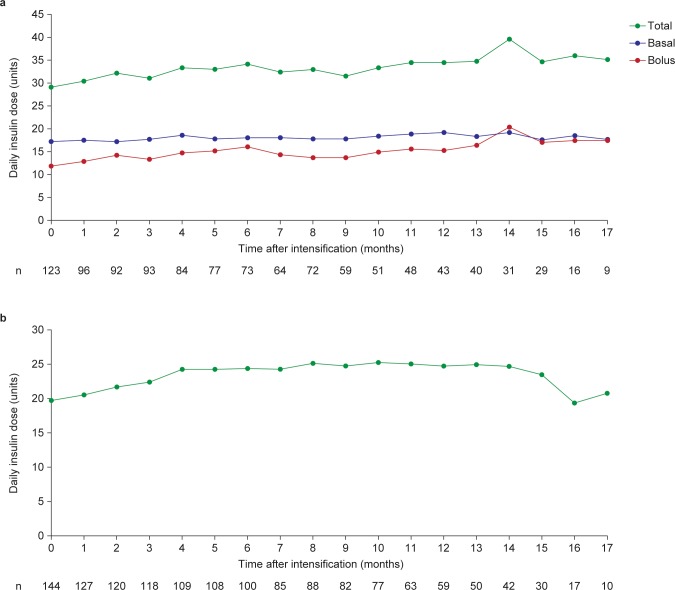
Daily insulin dose after intensification by insulin regimen a. basal–bolus insulin b. premix insulin. Data are observed mean based on the number of patients on a particular regimen at a given time point. n, number of patients with data for that time point. Patients who changed from basal–bolus insulin to premixed insulin, or vice versa, during the study contribute data to both panels of the figure.